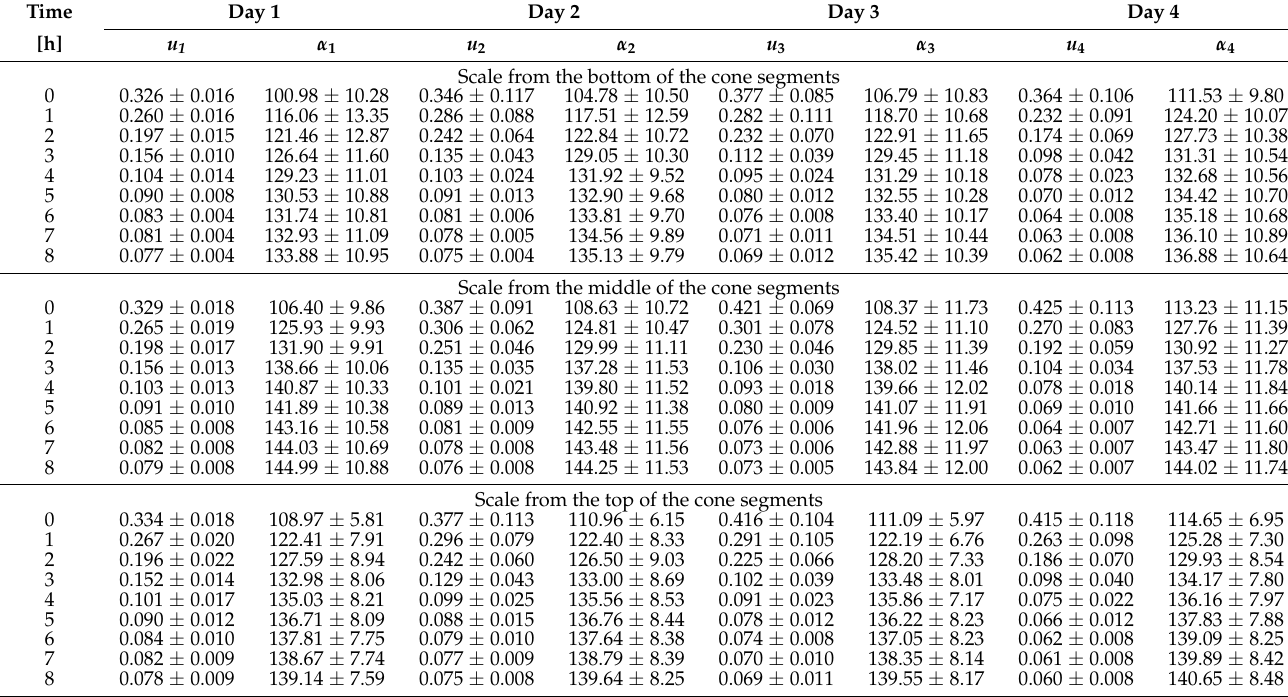
Table 2 shows mean moisture content values u 1 –u 4 and scale opening angles α 1 – α 4 together with standard deviations, measured in scales from the bottom, middle, and top cone segments for each hour of the studied seed extraction process. Table 2. Mean moisture content in cones and the corresponding opening angles of scales in the bottom, middle, and top cone segments over four consecutive days of